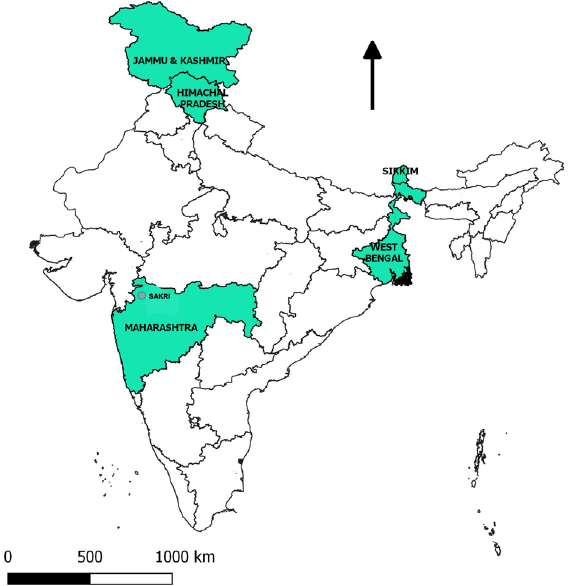
Figure 1. New collection locality and first record in the Western Ghats of the trogid beetle Omorgus ( Afromorgus ) italicus (Reiche,